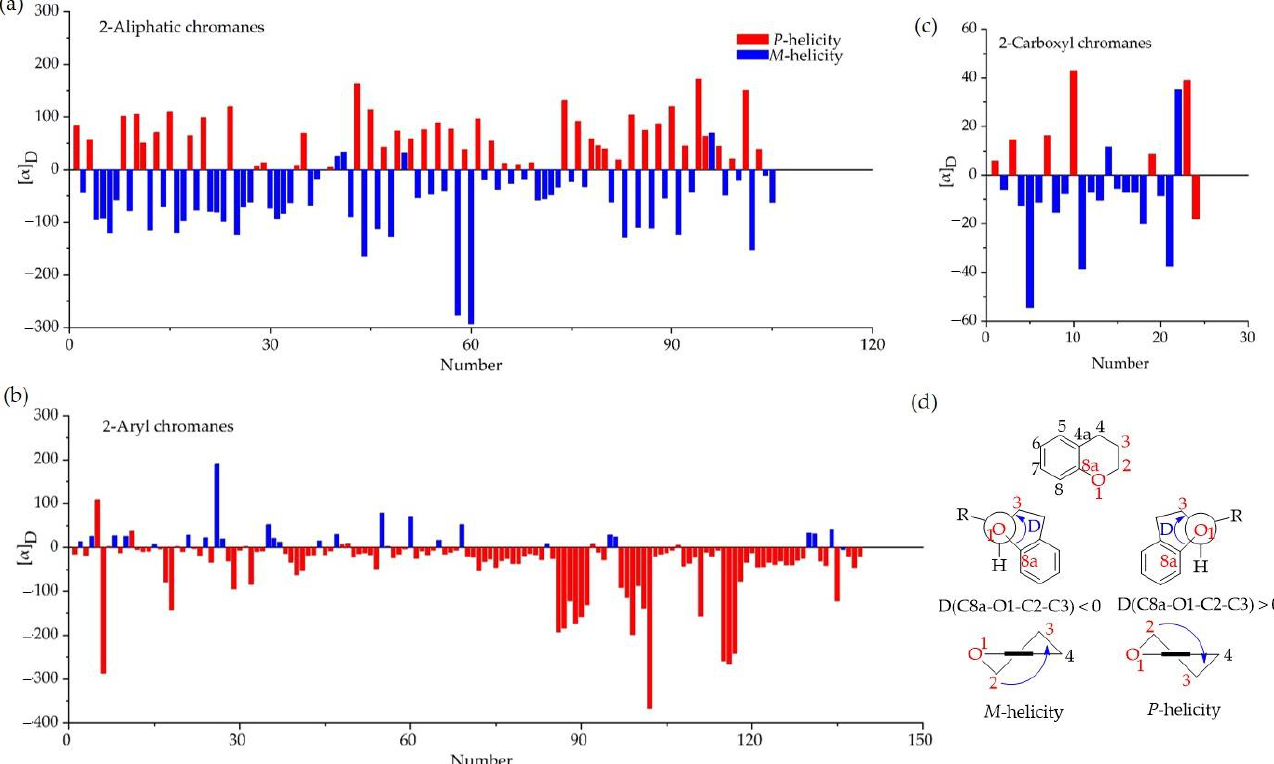
Figure 2. Histograms of the SORs of various chiral 2-substituted chromanes: ( a ) 2-aliphatic chromanes, ( b ) 2-aryl chromanes, and ( c ) 2-carboxyl chromanes; red: [ α ] D of chromanes in M -helicity, blue: [ α ] D of chromanes with P -helicity. ( d ) Graphical representation of the correlation between the P -/ M -helicity of the dihydropyran ring and the torsion angle